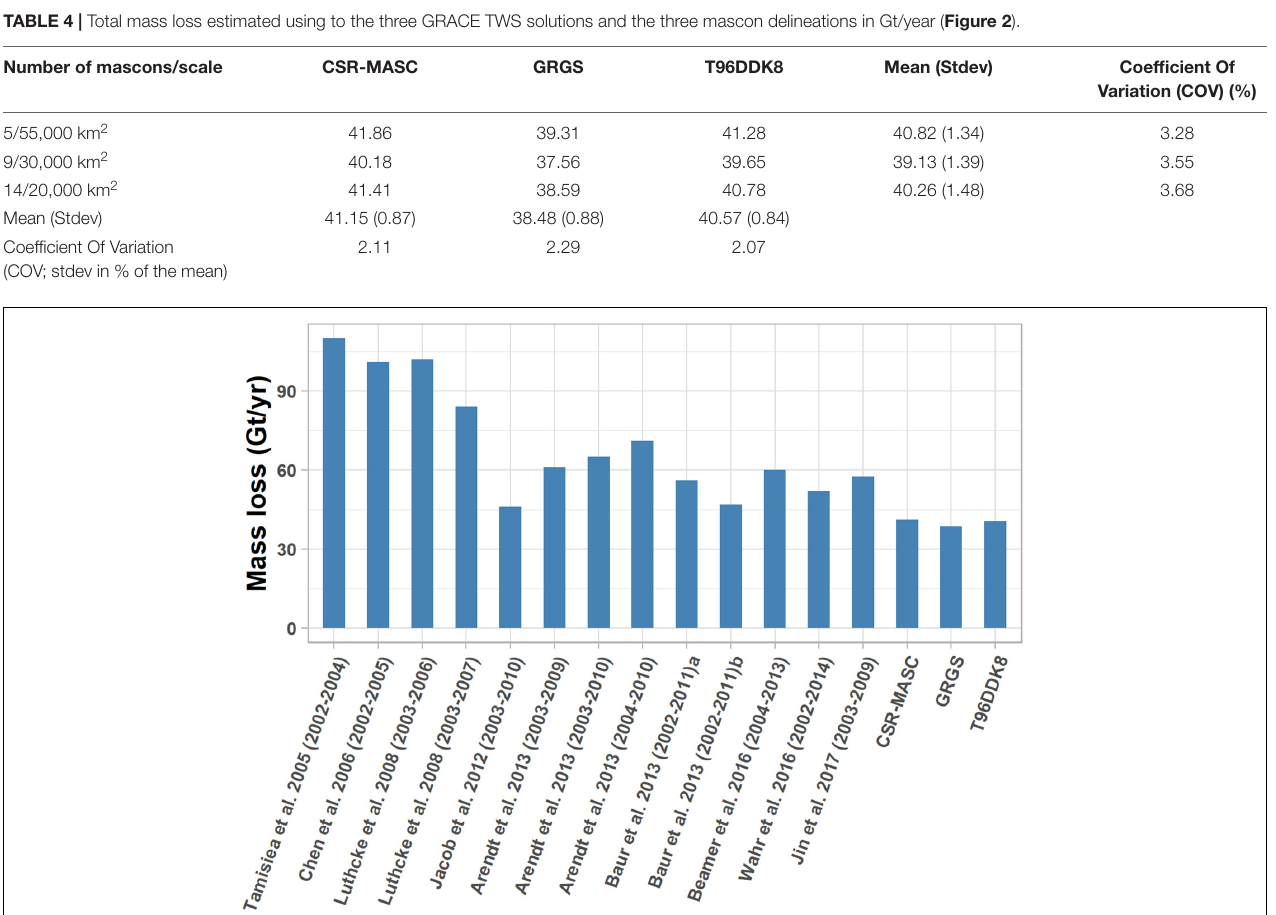
FIGURE 5 | Comparison between glacier mass loss estimates from this study with those of other studies listed in Table 1 .